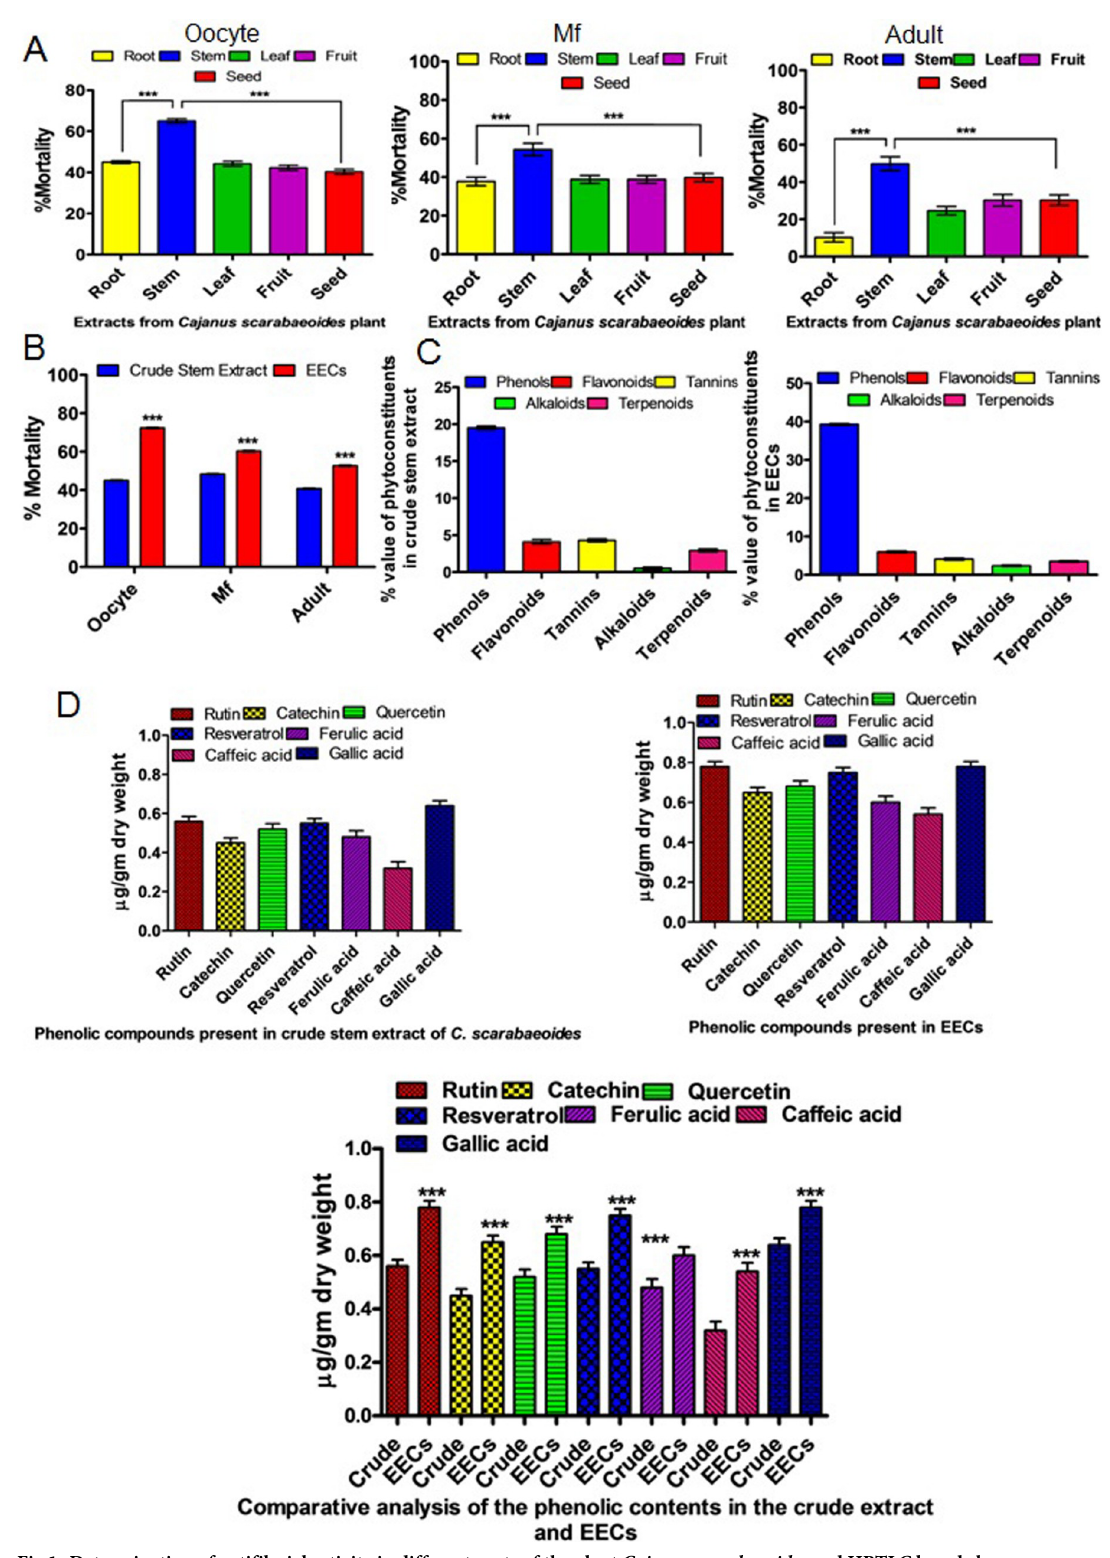
Fig 1. Determination of antifilarial activity in different parts of the plant Cajanus scarabaeoides and HPTLC based chemo- profiling of the ethanolic extract of C . scarabaeoides . A. Efficacy of ethanolic extracts prepared from the root, stem, leaf, fruit, and the